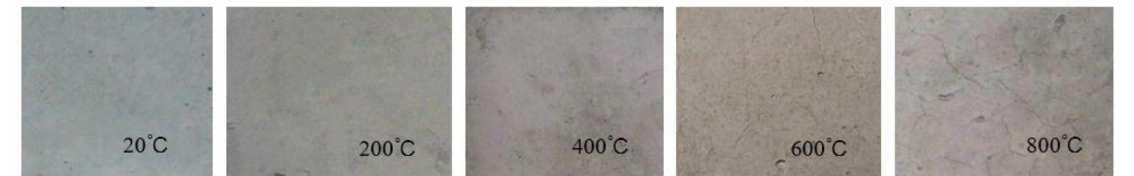
Figure 5. Apparent morphology of specimen after elevated